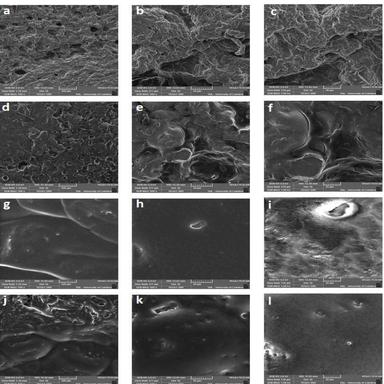
SEM images of fresh processed products at different magnifications. Pork ham (a, b and c), turkey ham (d, e and f), bacon, from a low fat content portion (g, h and i) and bacon, from a high fat content portion (j, k and l).